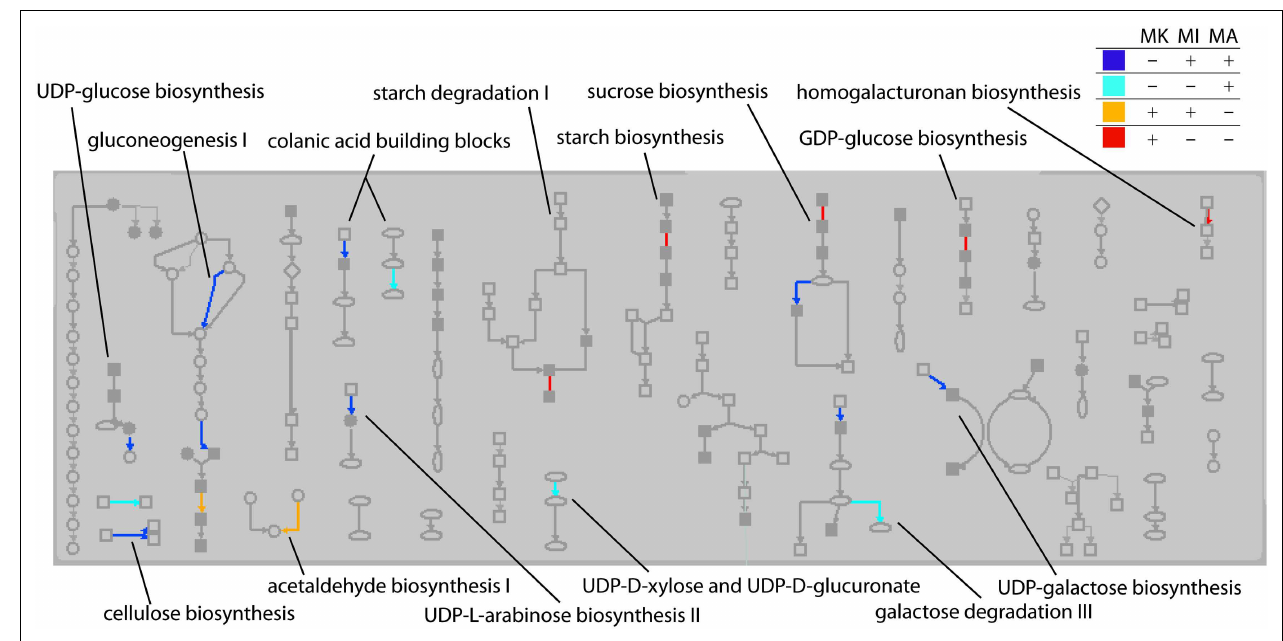
Mu killer are blue (“off” in Mu killer ) or red (“on” in Mu killer ). Reactions affected by both Mu killer and Mu inactive but not Mu active are either teal (“off” in Mu killer ) or orange (“on” in Mu killer